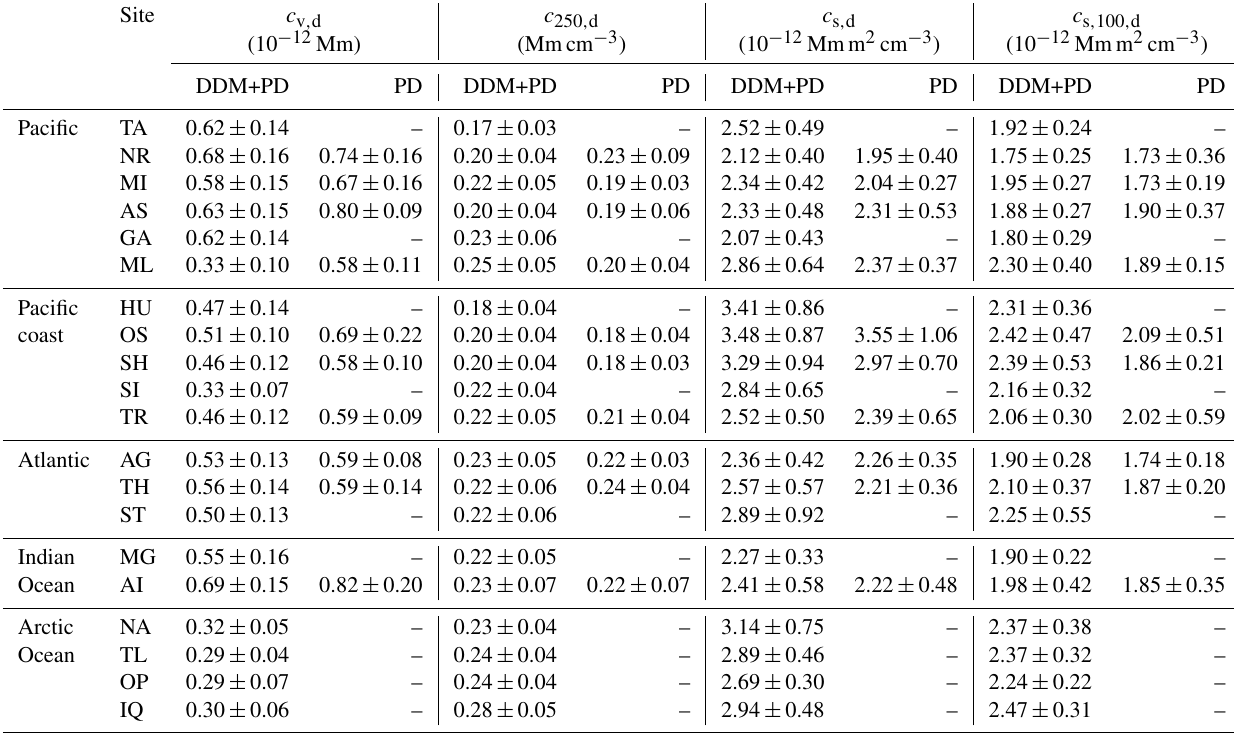
Table 4. POLIPHON dust-related conversion factors c v , d (in 10 − 12 Mm), c 250 , d (in Mmcm − 3 ), c s , d (in 10 − 12 Mmm 2 cm − 3 ), and c s , 100 , d (in 10 − 12 Mmm 2 cm − 3 ) for the dust-dominated mixture (DDM) plus pure dust (PD) and only PD based on the AERONET data analysis. The respective standard deviations are also provided. The sites are classified into five regional clusters, including the Pacific, Pacific coast, Atlantic, Indian Ocean, and Arctic